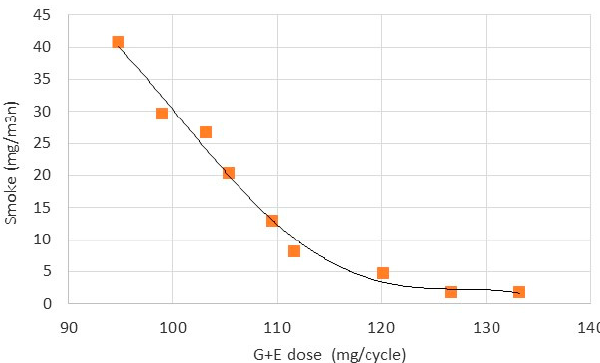
Figure 11. Smoke vs. glycerol-ethanol ( 𝐺 + 𝐸 ) dose.